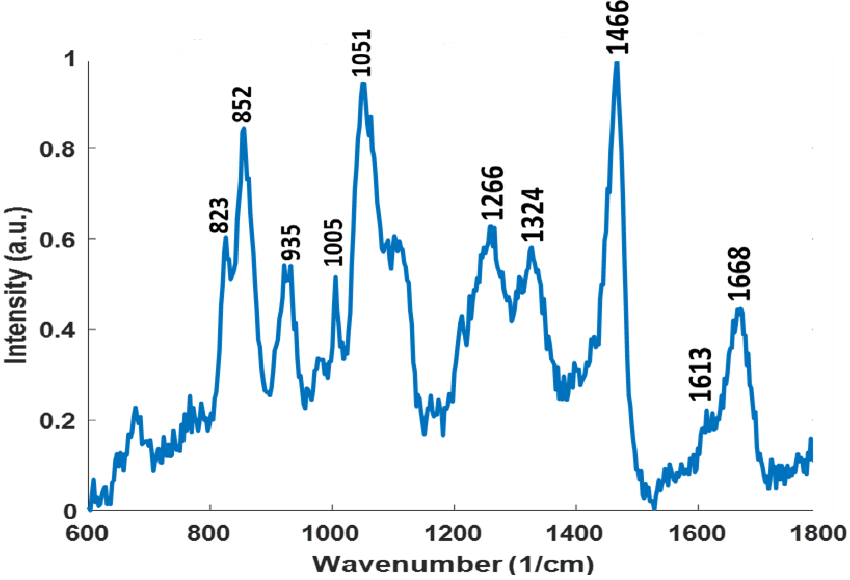
Figure 5. Mean Raman spectrum of purified recombinant iturin A.